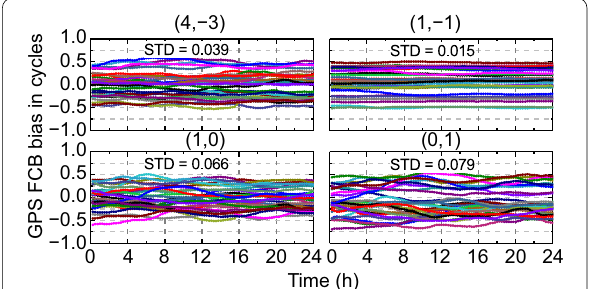
Fig. 6 GPS FCBs series for the (4, individuals of each frequency. Each color denotes one satellite FCB series